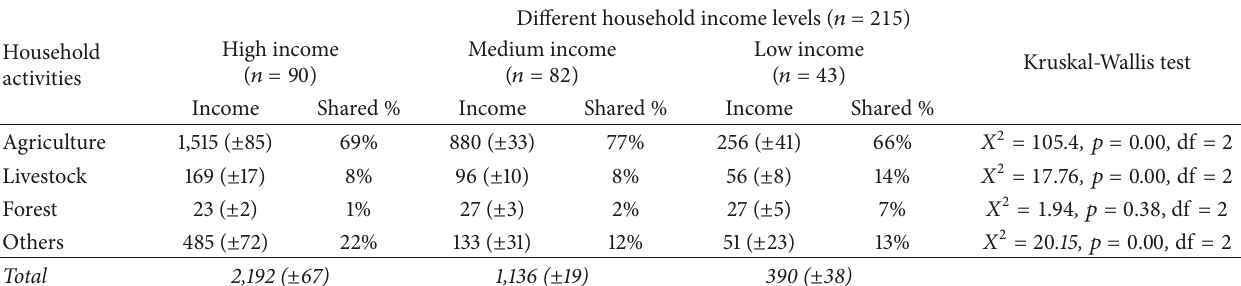
Table 4: Average annual total household cash income contribution by household activities (MMK ∗ , 000).